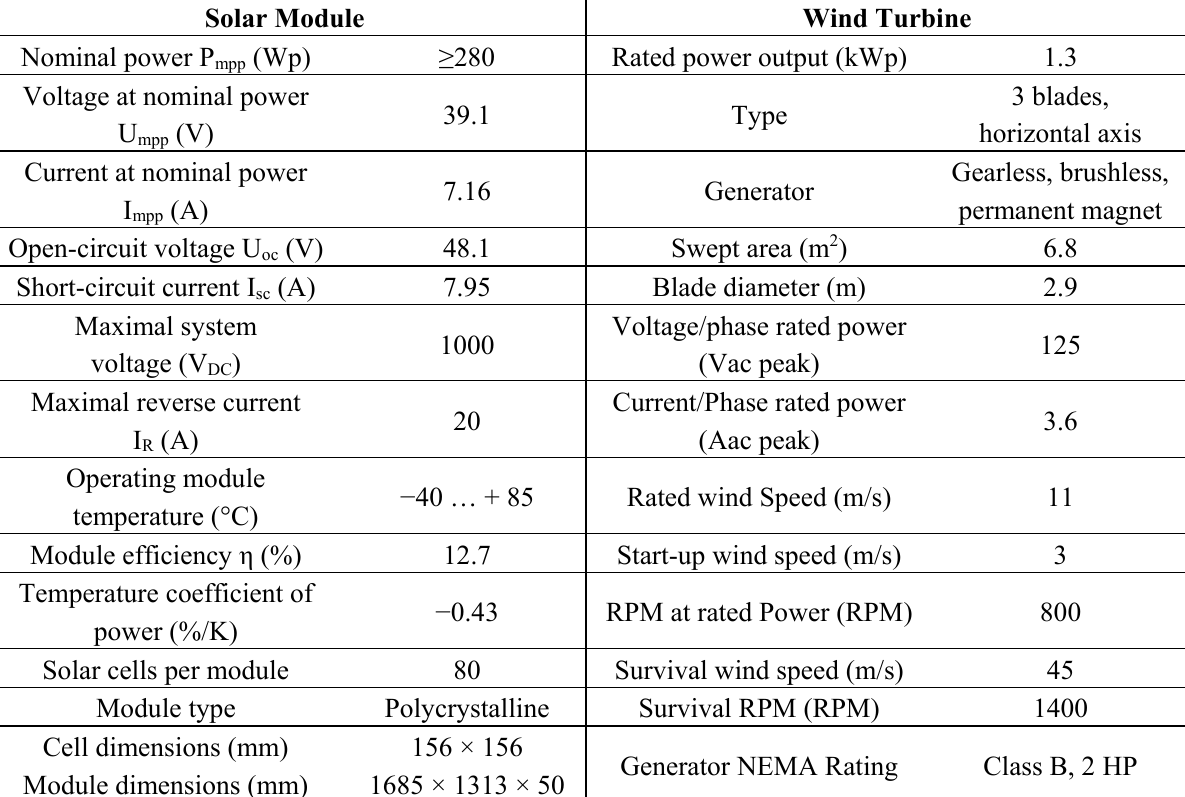
Table 3. Technical data of solar modules and wind turbines installed on analyzed green